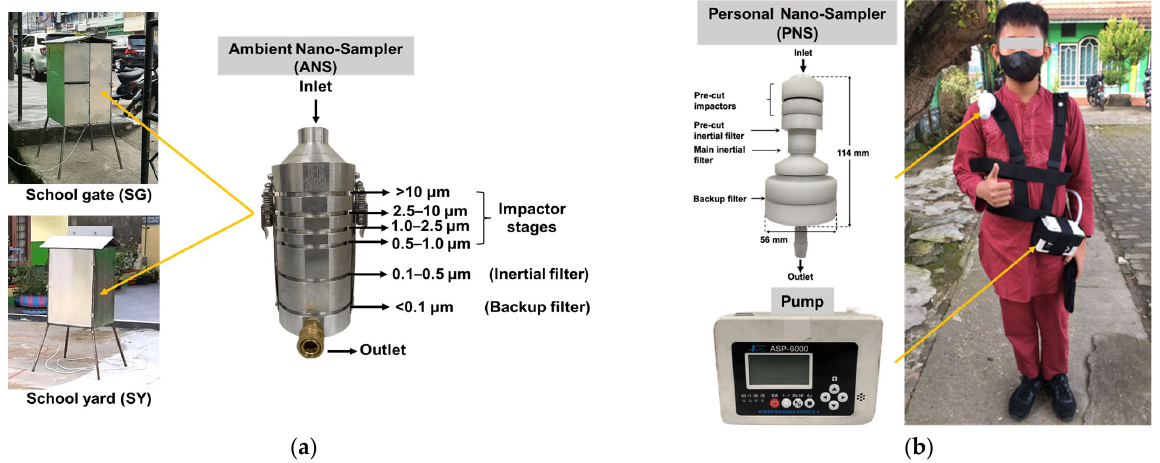
Figure 2. ( a ) Ambient Nano ‐ Sampler (ANS) and ( b ) Personal Nano ‐ Sampler (PNS) and description of use in field samplings. of use in field